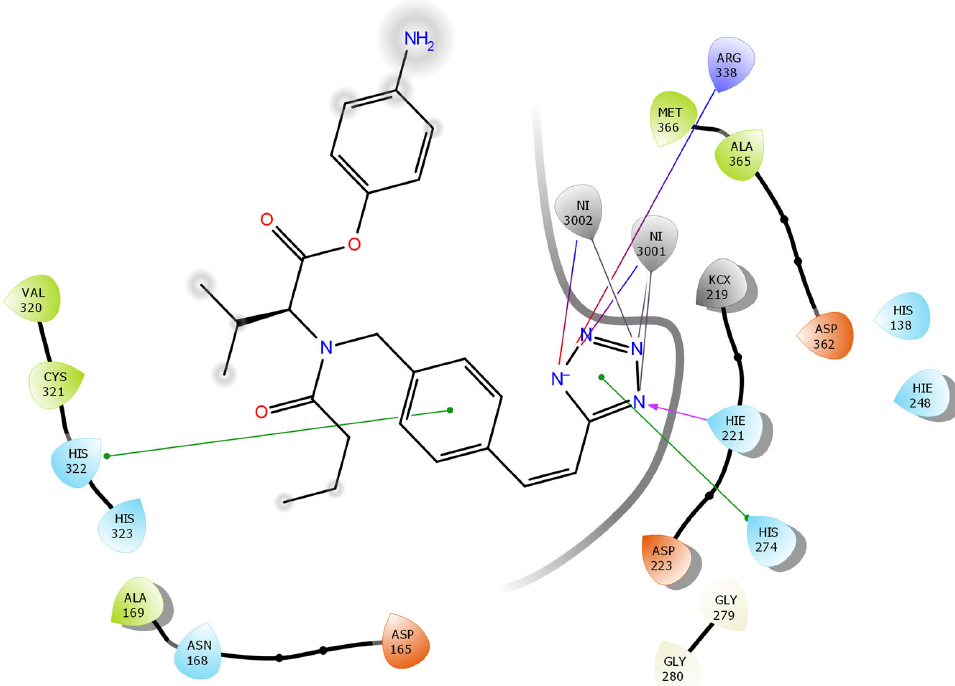
Figure 2. 2D Best Docking pose of the derivative AV4 with H. pylori urease .